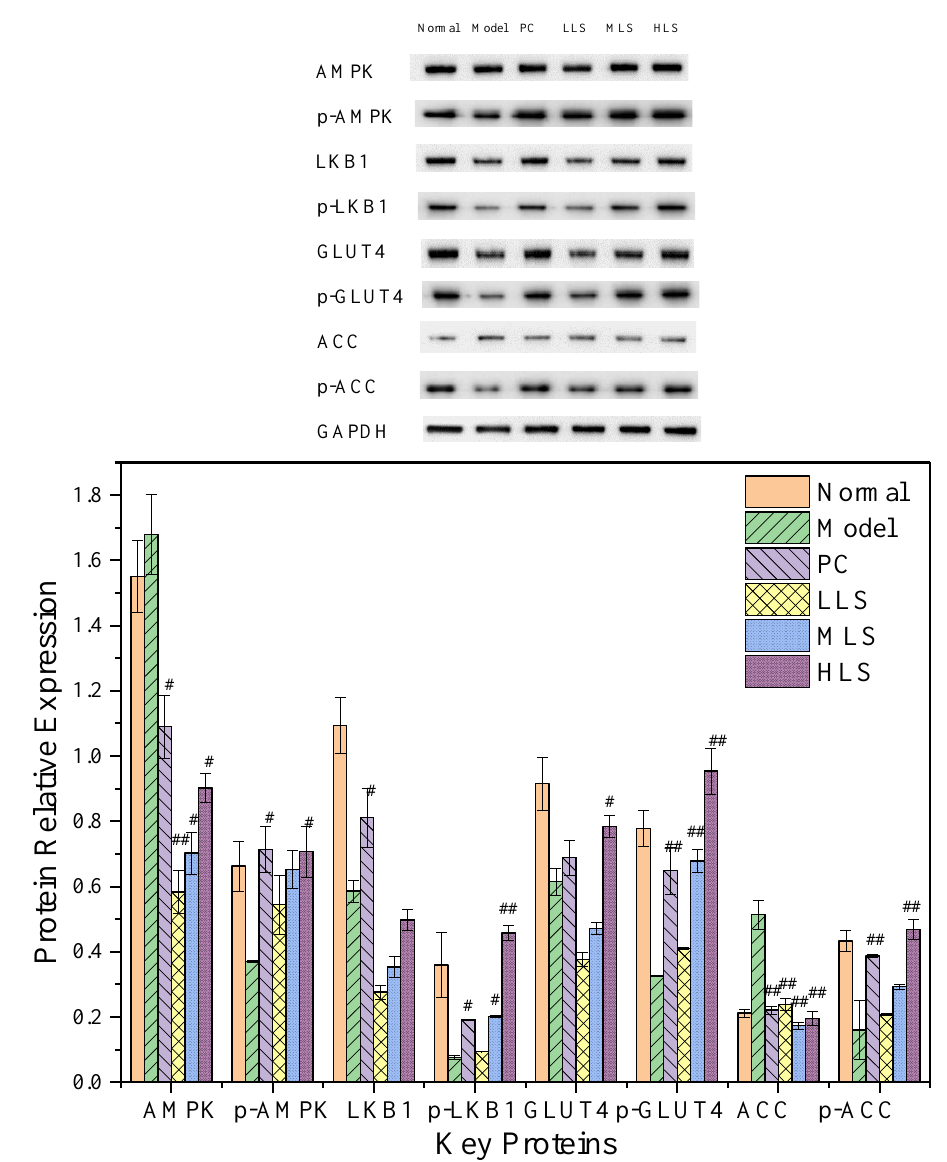
Figure 3. Effect of sericin on the expression of key AMPK/ACC proteins in T2D rats. Normal: normal group; Model: diabetic model group; PC: 0.5% melbin; LLS, MLS, and HLS: 1%, 2.5%, and 5 % LS. n = 3, # p < 0.05, ## p < 0.01 versus model group.